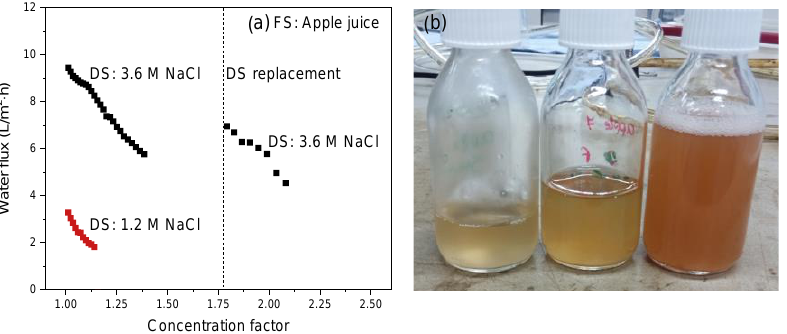
Figure 8. ( a ) Water flux as a function of the concentration factor using apple juice as FS. The intermission in the curve is due to the refreshing of the DS to reset it to 3.6 M NaCl; ( b ) freshly squeezed apple juice ( left bottle ) and the concentrated feed at two stages in the FO-concentration process.